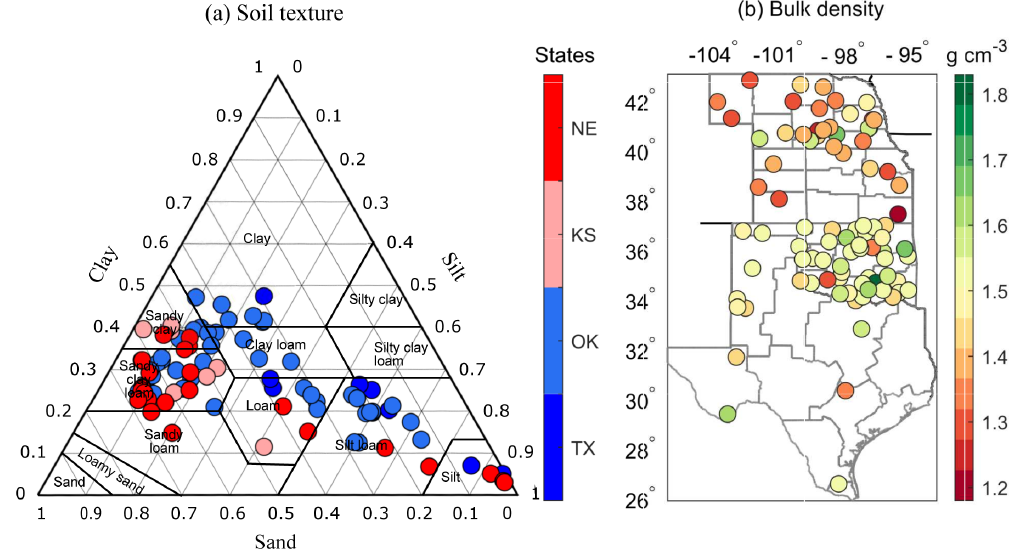
Figure 1. Specific soil textures (a) and soil bulk density (b) at 87 weather stations in the USA winter wheat belt, including the states of Nebraska (NE), Kansas (KS), Oklahoma (OK), and part of Texas (TX) in the USA Great